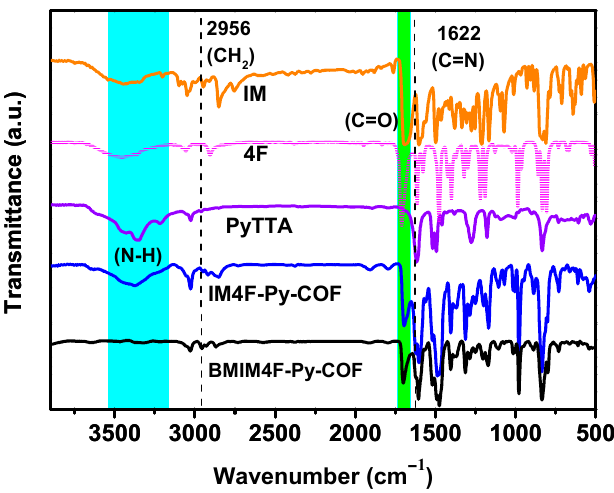
Figure 2. FT-IR spectra of IM4F-Py-COF (blue), BMIM4F-Py-COF (black), IM (orange), 4F (magenta) and PyTTA (violet).